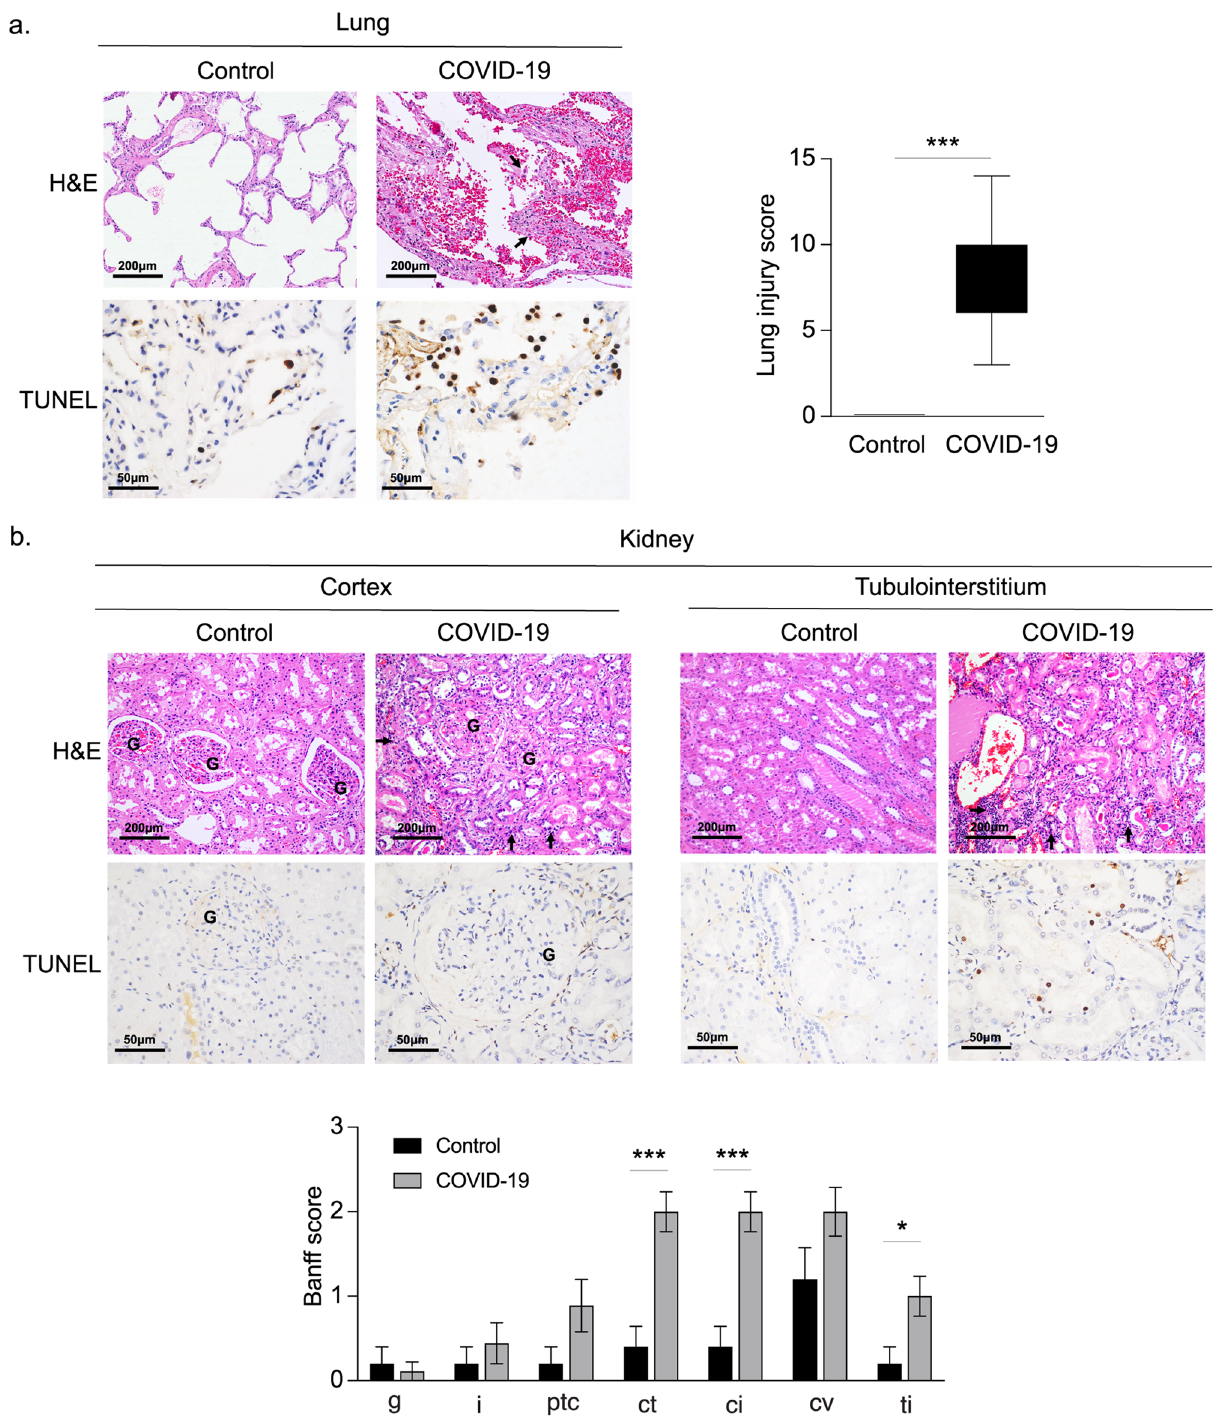
Figure 6. Histopathology findings of lung and kidney in COVID19 patients and controls. Representative H&E and TUNEL staining in ( a ) lung and ( b ) kidney tisuses from patients with COVI19 (COVID-19, n = 9) and controls (Control, n = 5). Black arrows indicate mononuclear inflammatory cells. Lung injury was assessed on a scale of 0–2 for each of the following criteria: (i) alveolar polymorphonuclear neutrophils, (ii) chronic alveolar inflammation/macrophages, (iii) acute alveolar wall Inflammation, (iv) chronic alveolar wall inflammation, (v) hyaline membranes, (vi) Type 2 hyperplasia only, (vii) Type 2 hyperplasia with fibroblasts, and (viii) organizing pneumonia and squamous metaplasia. The final injury score was derived from the following calculation: Score = I + ii + iii + iv + v + vi + vii + viii. G indicates glomerulus. Banff Score: g, glomerulitis; i, interstitial inflammation; ptc, peritubular capillaritis; ct, tubular atrophy; ci, interstitial fibrosis; cv, vascular fibrous intimal thickening; ti, total inflammation. *p < 0.05, **p <